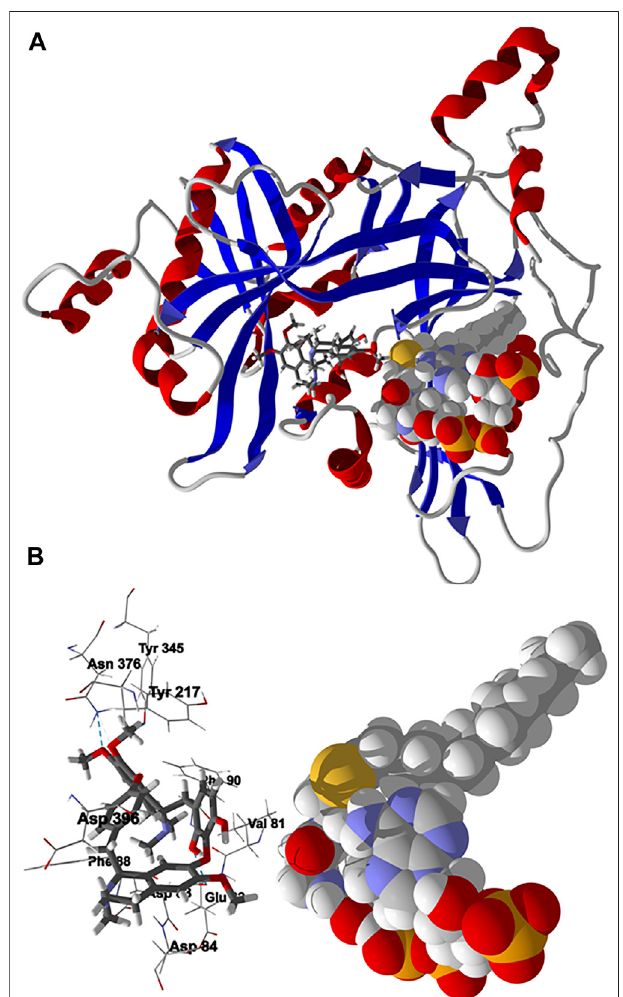
FIGURE 7 | Lowest-energy docked pose of chondrofolinol with Leishmania major N -myristoyltransferase (Lmaj NMT, PDB 2WSA). (A) : Ribbon structure (the myristoyl CoA cofactor is shown as a space- fi lling structure and the docked chondrofolinol is shown as a stick fi gure). (B) : Activesiteshowingtheinteractionsofimportantcontactsintheactivesitewith the docked ligand (hydrogen-bonded interactions are indicated with blue dashed